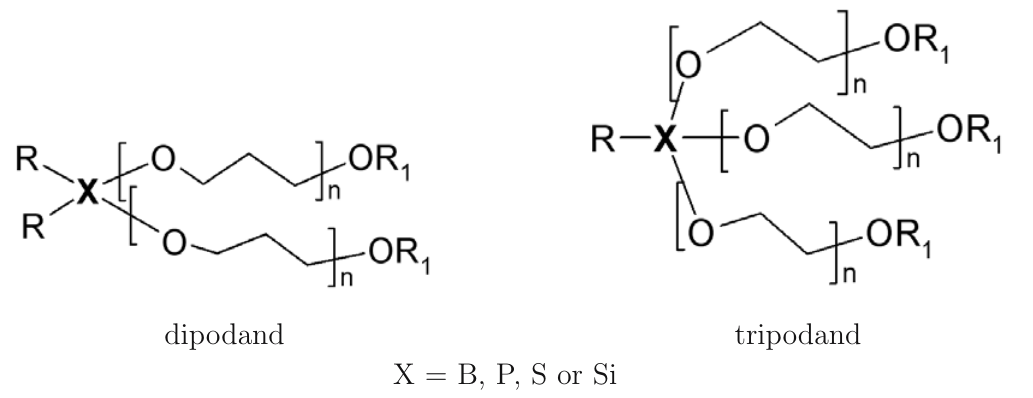
Fig. 1 Di- and tri-podands with polyoxaalkyl